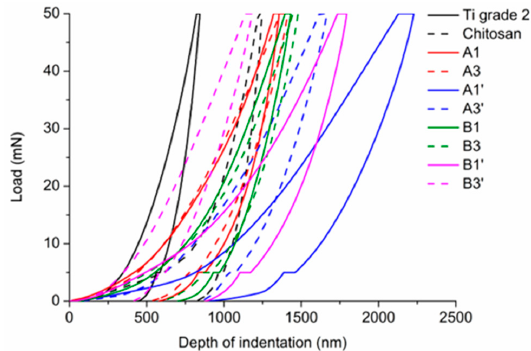
Figure 4. Hysteresis plots of load-deformation for a single indentation measurement for the Ti grade 2 substrate, chitosan, and chit/EE100 coatings.